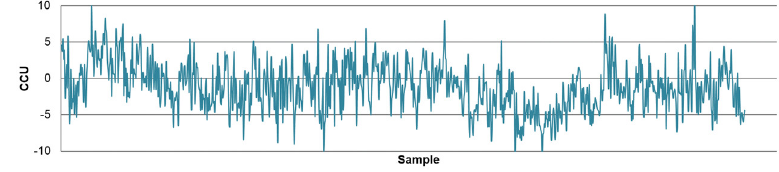
Figure A15. Prediction error of PMM model training dataset for CCU output variable.